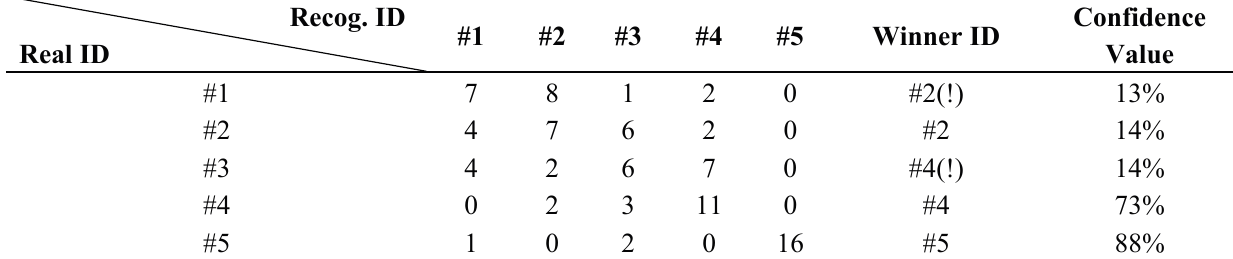
Table 6. Vote matrix of the proposed human identification solely based on Silhouette. Recog. ID